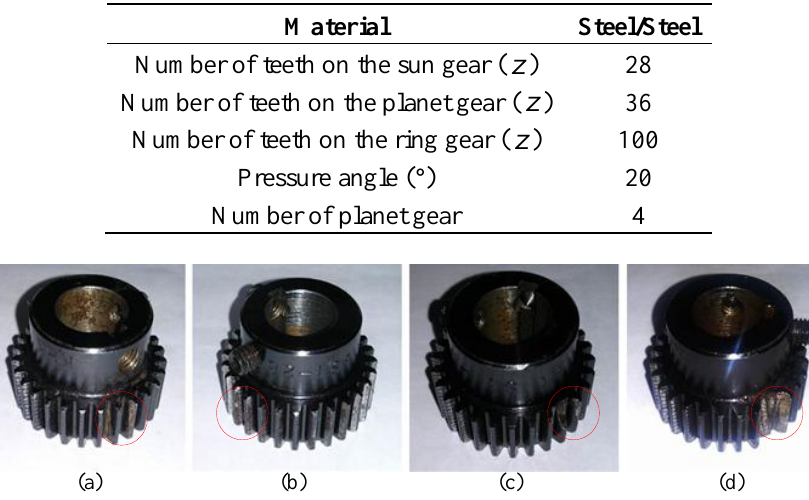
Figure 13. The four sun gears with different damages: ( a ) cracked tooth; ( b ) pitted tooth; ( b ) chipped tooth; ( c ) missing tooth.